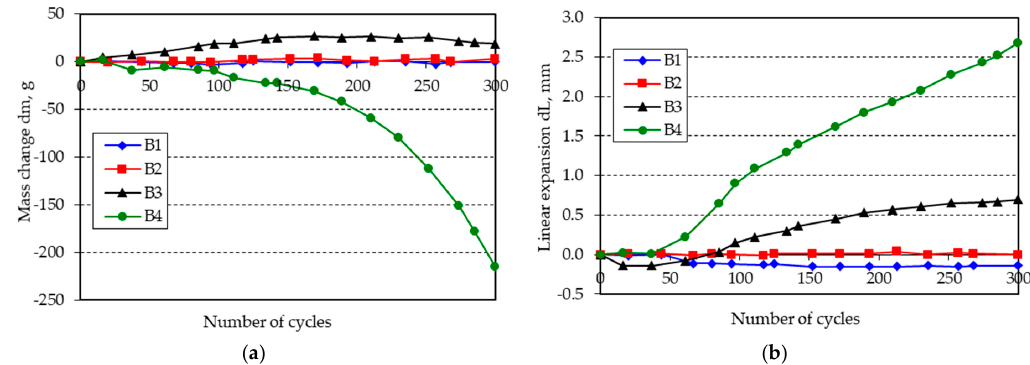
Figure 1. ( a ) Mass change; ( b ) linear expansion of specimens A1–A4 following freezing and thawing in water.